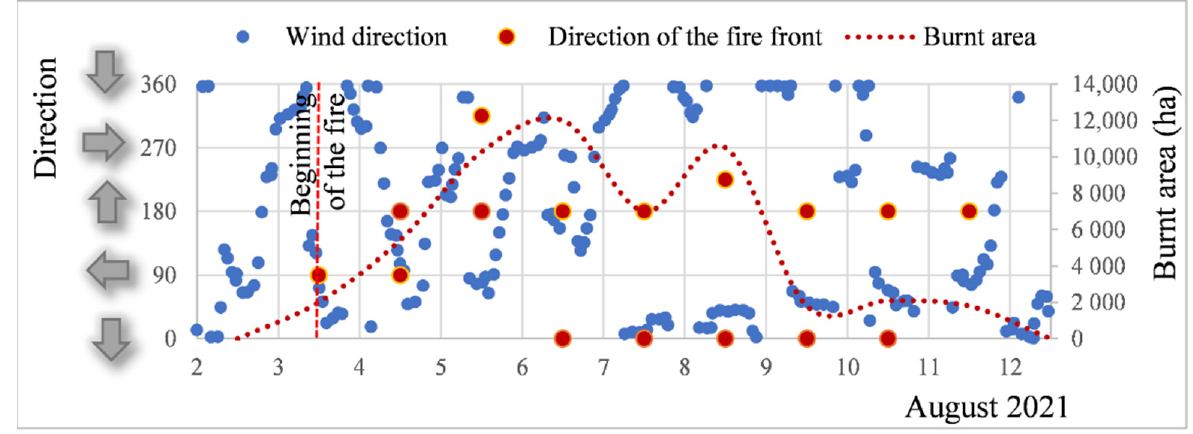
Figure 11. Wind direction (blowing to); 0, 360 North, 270 West, 180 South, 90 East [81].